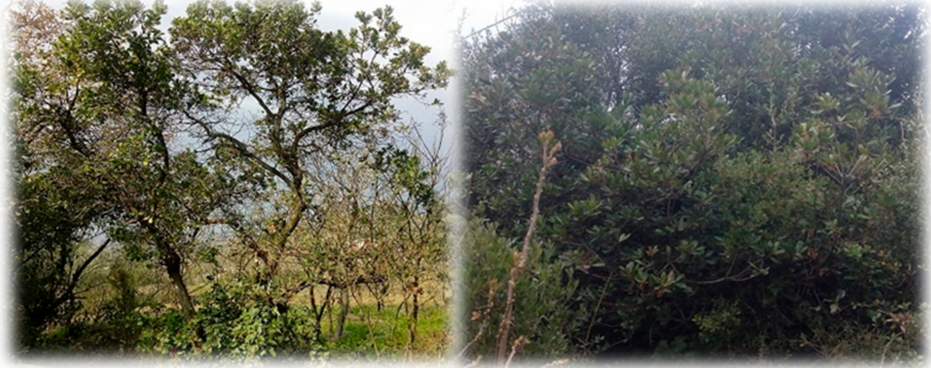
Figure 1. Naturally growing plants of Arbutus unedo L. genotypes (YV2 and YV4) in the forest land.